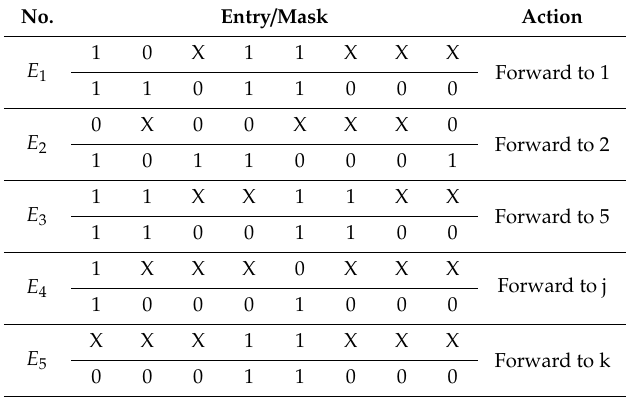
Table 1. An example of flow table with